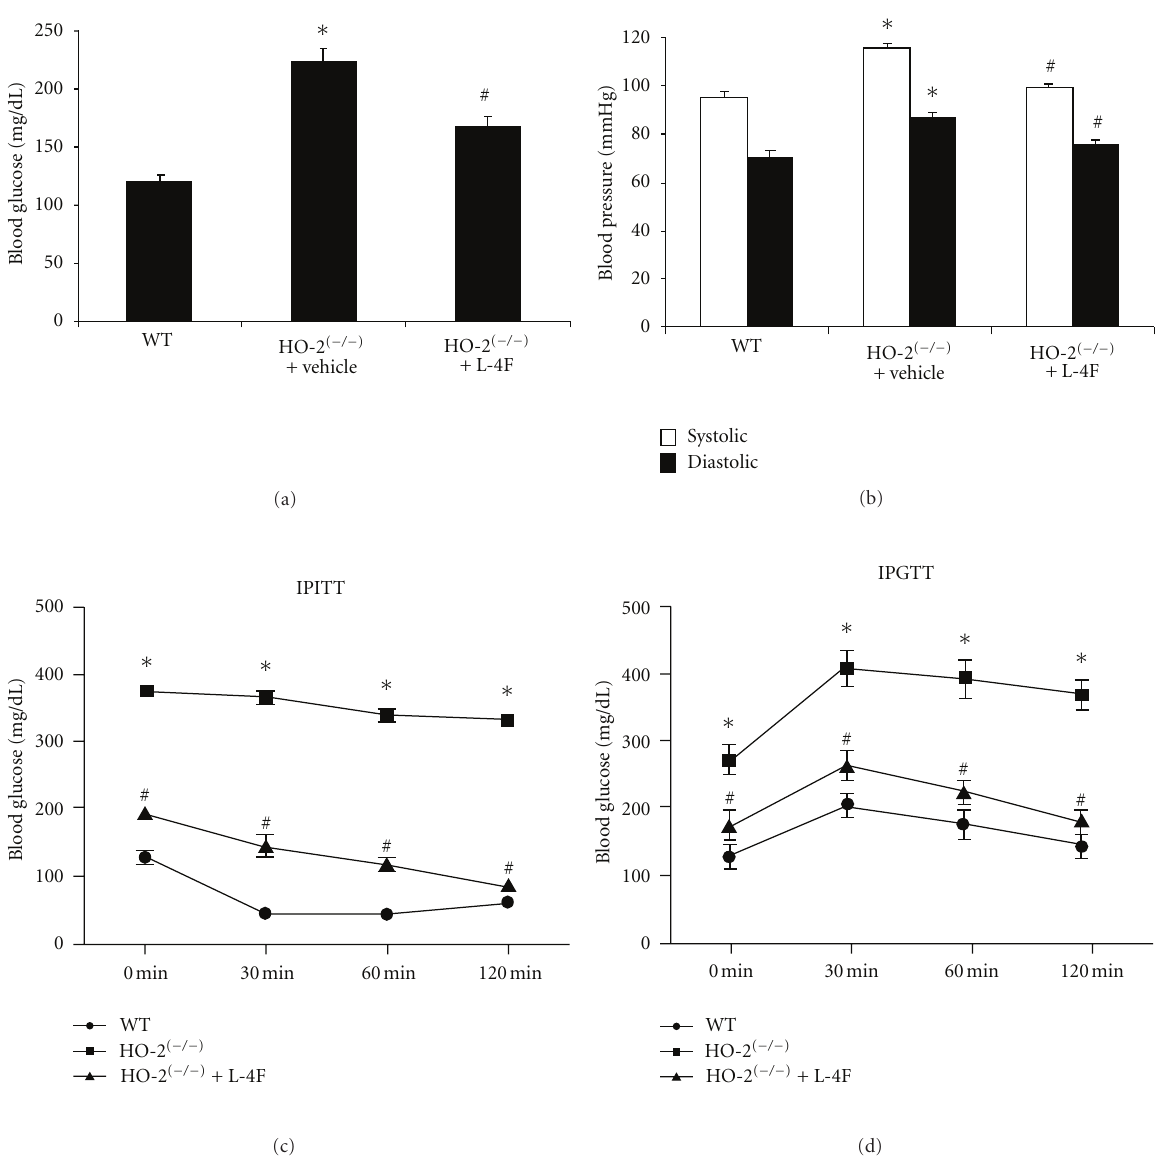
Figure 2: E ff ect of L-4F on blood glucose, blood pressure, insulin sensitivity, and glucose tolerance in HO-2 null mice. (a) Blood glucose. Values are means ± SE, n = 6, ∗ P < 0 . 05 versus WT; # P < 0 . 05 versus HO-2 ( − / − ) . (b) Blood pressure values are means ± SE, n = 6, ∗ P < 0 . 05 versus respective WT, # P < 0 . 05 versus respective HO-2 ( − / − ) . HO-2 ( − / − ) . (c) Intraperitoneal insulin sensitivity (IPITT) and glucose tolerance (IPGTT) (d) tests were performed as described in research designs and methods. Results are means ± SE, n = 6. (IPITT) ∗ P < 0 . 05 versus WT, # P < 0 . 05 versus HO-2 ( − / − ) , (IPGTT). ∗ P < 0 . 05 versus WT, # P < 0 . 05 versus HO-2 ( − / − )